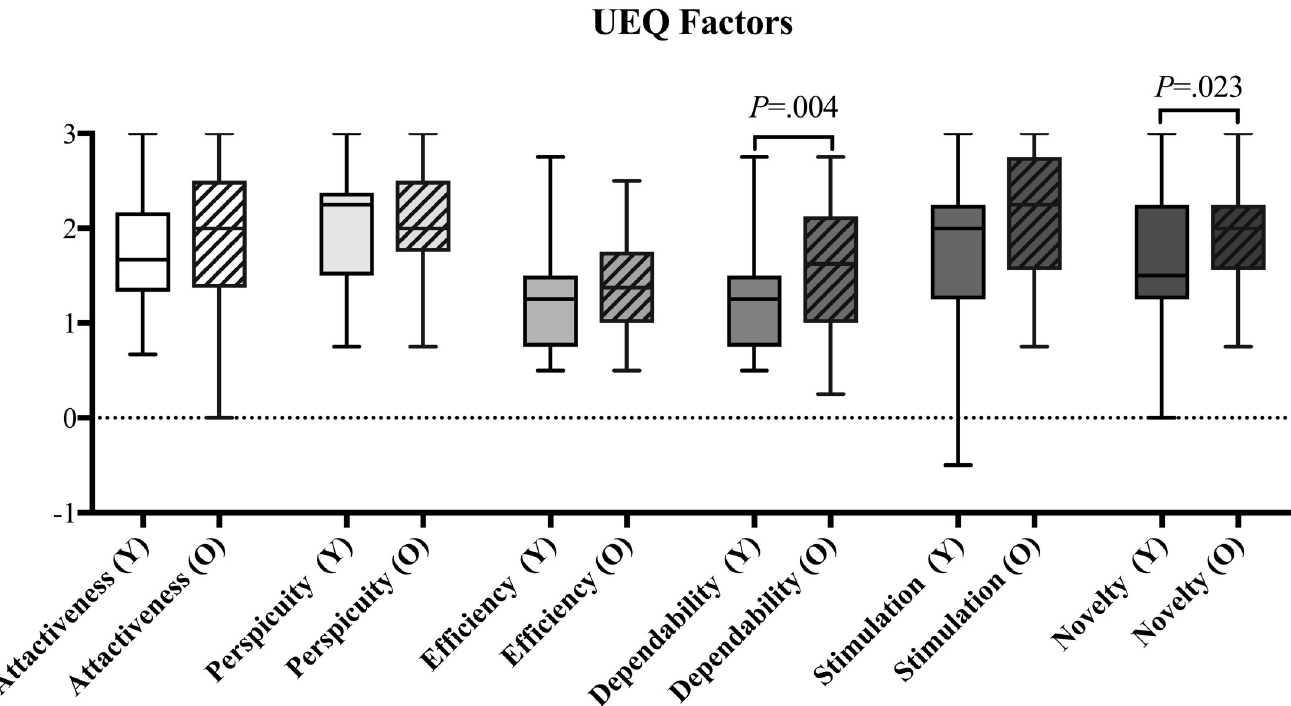
Fig 3. Boxplot of User Experience factors for the Younger group (Y), and for the Older group (O), showing large variability for most factors in both groups. All factors showed differences in the median, but only Dependability and Novelty showed differences on a significant level. Whiskers indicate the 25 th and 75 th